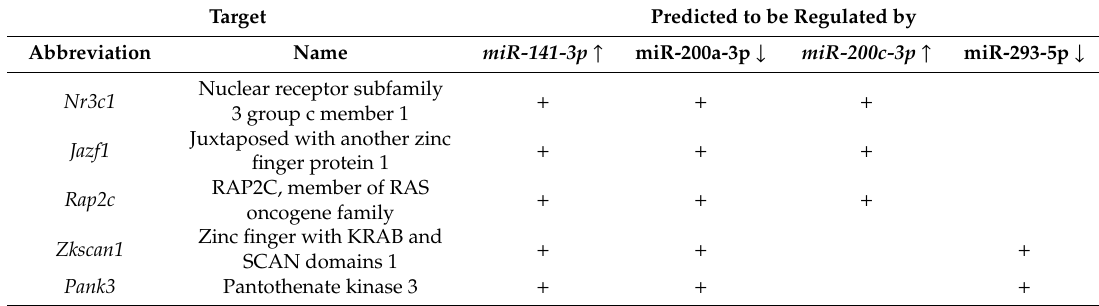
Table 2. Selected target genes indicating their miRNA connections. ↓ indicates downregulation and ↑ indicates upregulation of the selected gene targets in the prediabetic group as compared to those in the control group, + indicates predicted interaction between the selected target genes and the differentially expressed miRNAs. Target